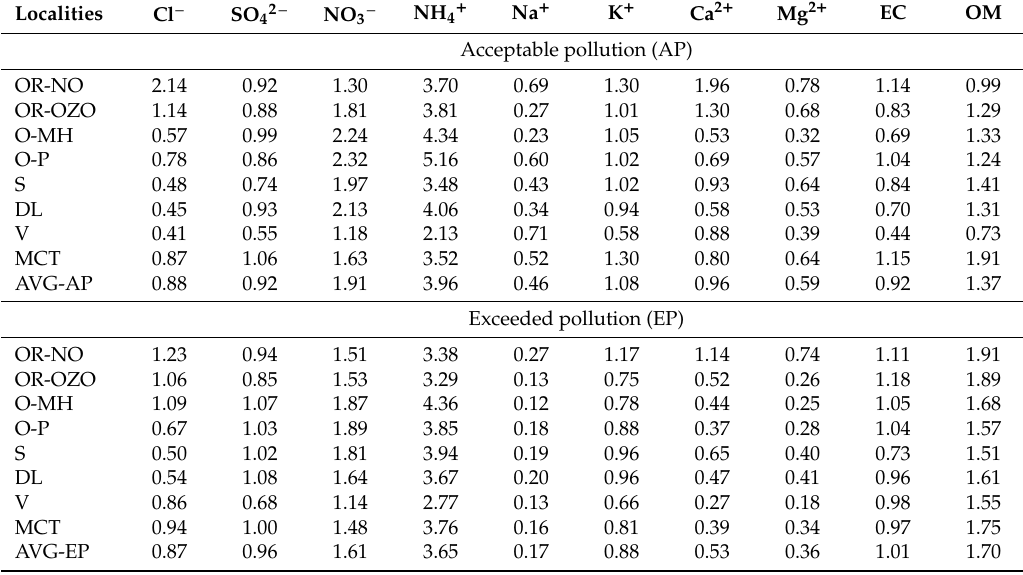
Table 2. Enrichment factors for the period of acceptable and exceeded pollution using the background values of